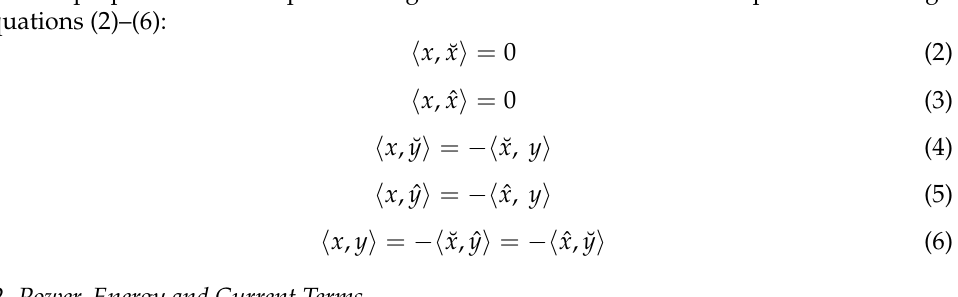
Table 1. Variables and mathematical operators. Mean value x = (cid:104) x (cid:105) = 1 Instantaneous time derivative ˘ x ( t ) = dx ( t ) Instantaneous time integral x S ( t ) = (cid:82) t Impartial integral ˆ x ( t ) = x S ( t ) − x S Inner product (cid:104) x , y (cid:105) = 1 Effective